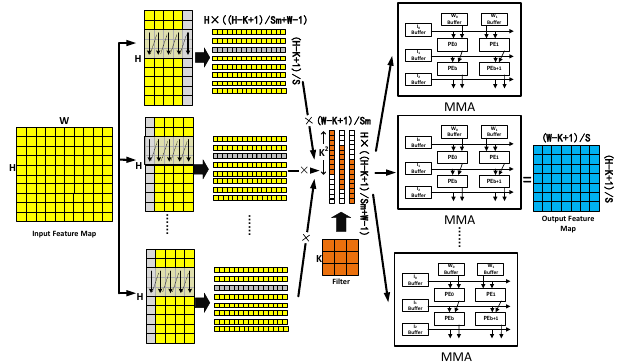
Figure 5. The block parallel computing algorithm based on MTCA.